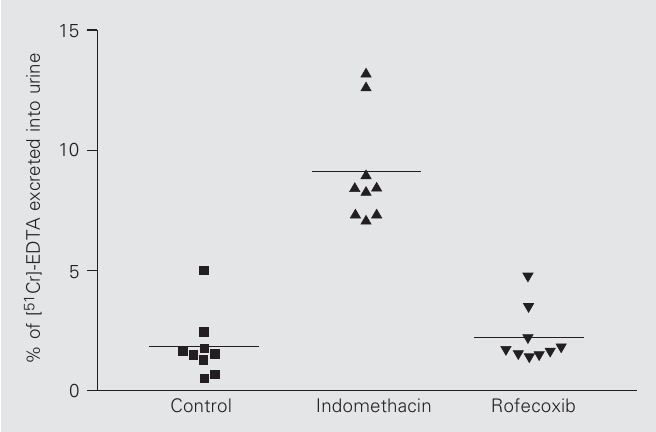
Figure 2. Scatter diagram showing individual mean percent [ 51 Cr]-EDTA ex- creted into urine for control rats (N = 9) and rats treated by gavage with a single dose of 7.5 mg/kg indomethacin (N = 9) and 2.5 mg/kg rofecoxib (N = 9). The horizontal lines indicate the mean. P < 0.05 for control vs indomethacin and rofecoxib vs indomethacin. Statistical differences in intestinal permeability among groups were assessed by one-way analysis of variance and Bonferroni’s multiple comparison test.